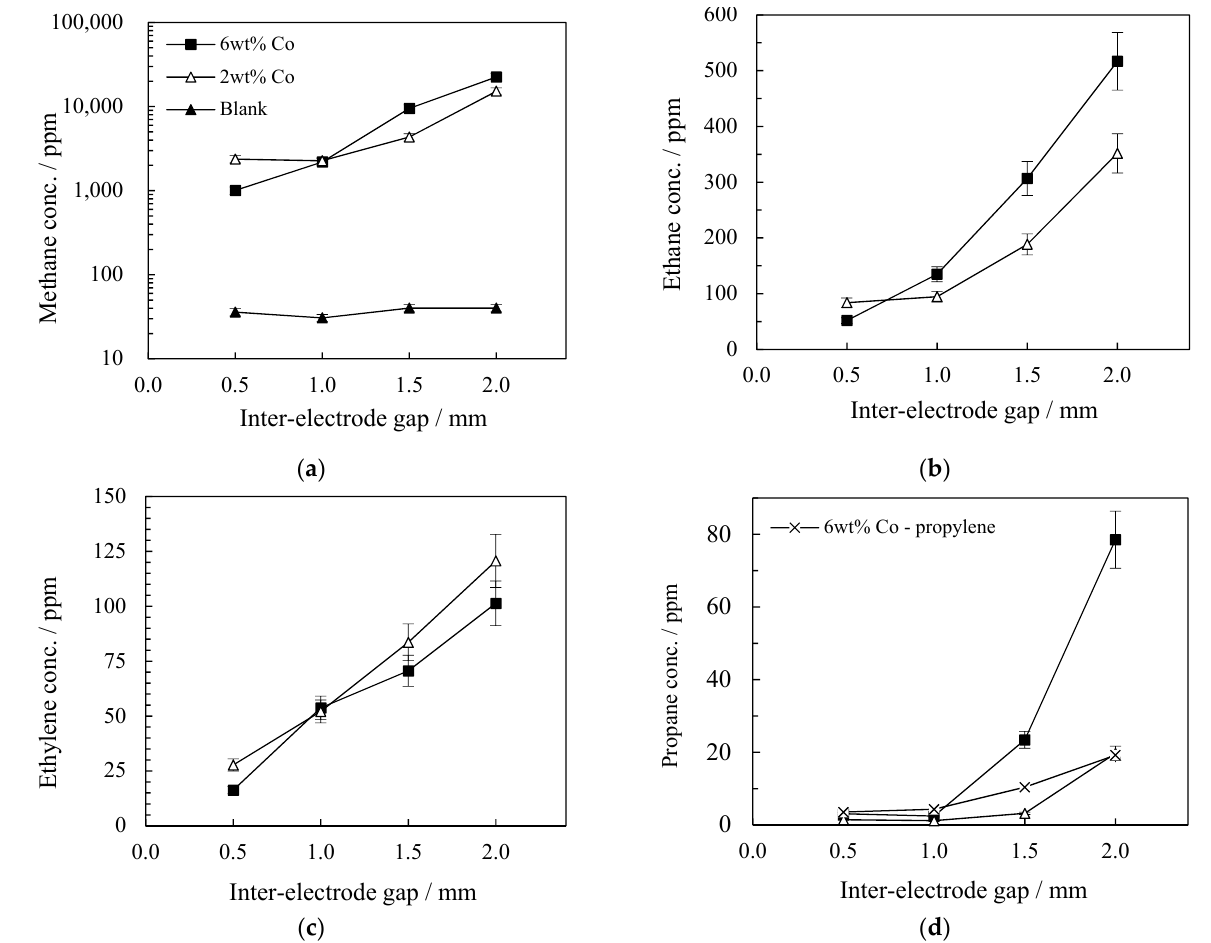
Figure 11. The influence of inter-electrode gap on hydrocarbon concentration for plasma-catalytic FTS (NTP + Blank, 2 or 6 wt% Co catalyst) at a discharge time of 60 s; ( a ) methane, ( b ) ethane, ( c ) ethylene and ( d ) propane/propylene. Legend: (cid:4) —6 wt% Co; ∆ —2 wt% Co; (cid:78) —Blank; X—6 wt% Co (propylene). Operating conditions: Syngas (H pressure: 2 MPa; current: 350 mA; wall temperature: 25 ◦ C. Error bars (vertical): Expanded experimental hydrocarbon concentration uncertainty of ±